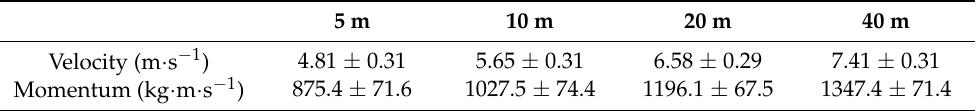
Table 3. Descriptive data (mean ± standard deviation) of the sprint velocity and momentum in the different distances